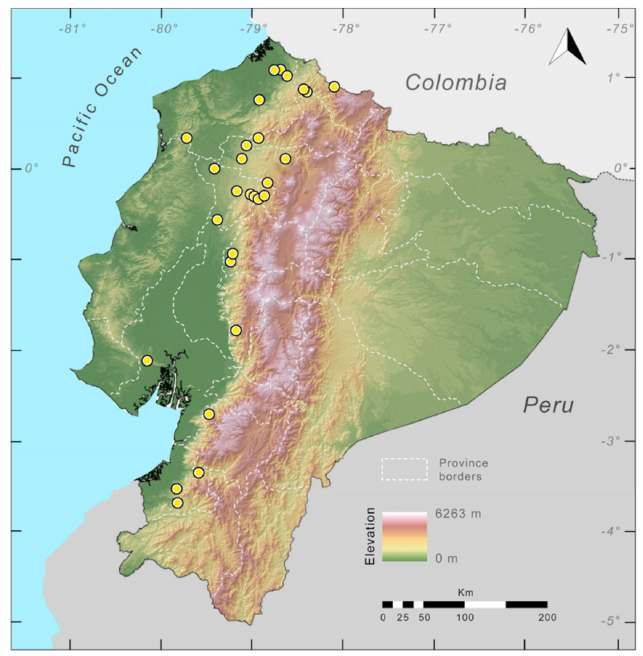
Figure 97. Distribution of Espadarana prosoblepon in Ecuador (yellow